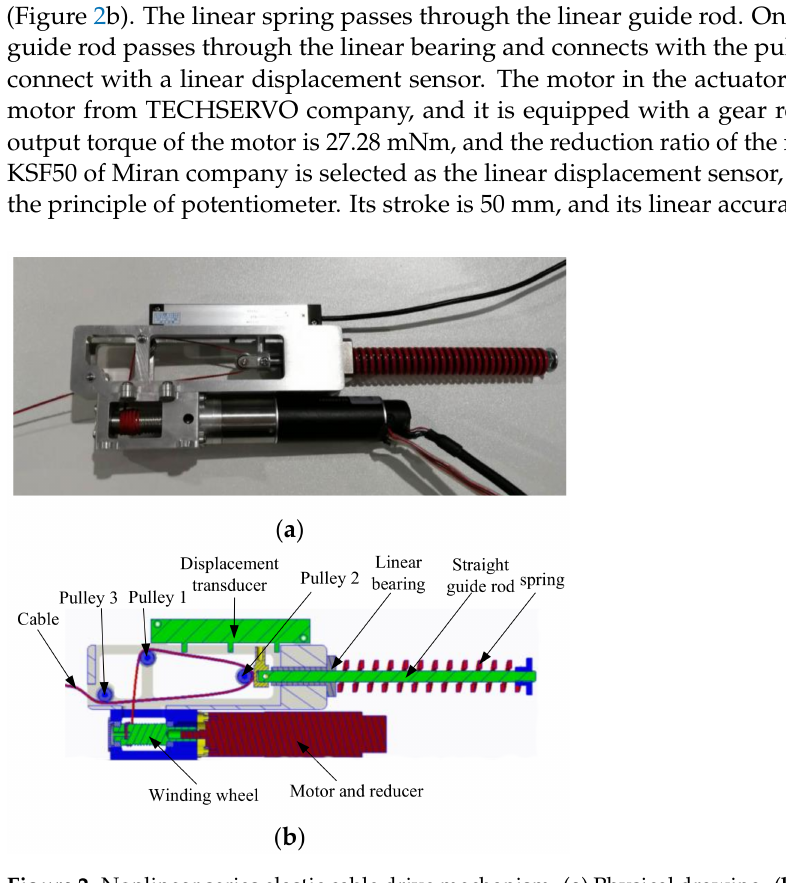
Figure 2. Nonlinear series elastic cable drive mechanism. ( a ) Physical drawing. ( b ) Sectional